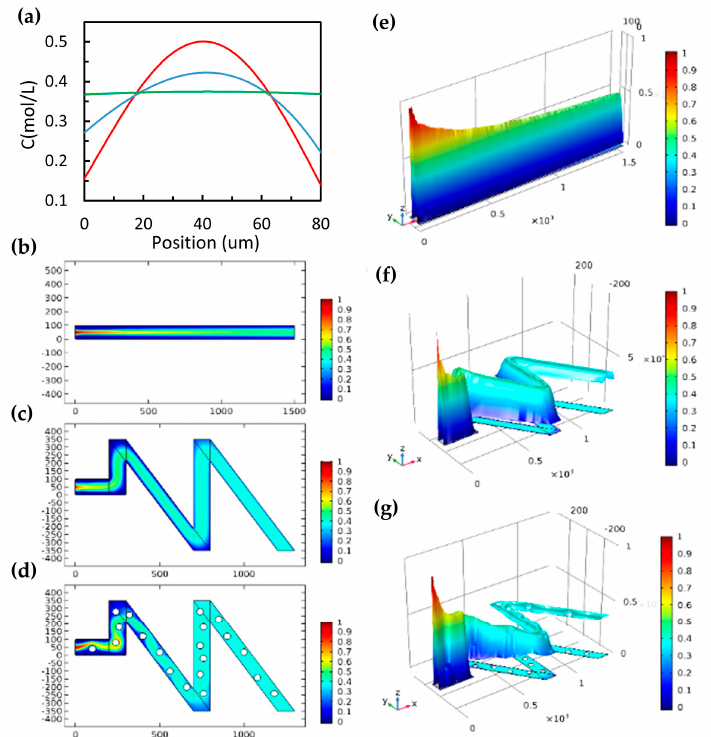
Figure A1. Simulation of liquids mixing in microchannel with different designs. ( a ) Cross-sectional concentration profiles of straight channel (red line), Z-shape channel (blue line) and Z-shape channel with blocks (green line) at x = 1000 µm. ( b – d ) Stable concentration distribution in main channel by simulation. ( e – g ) Corresponding height curves.